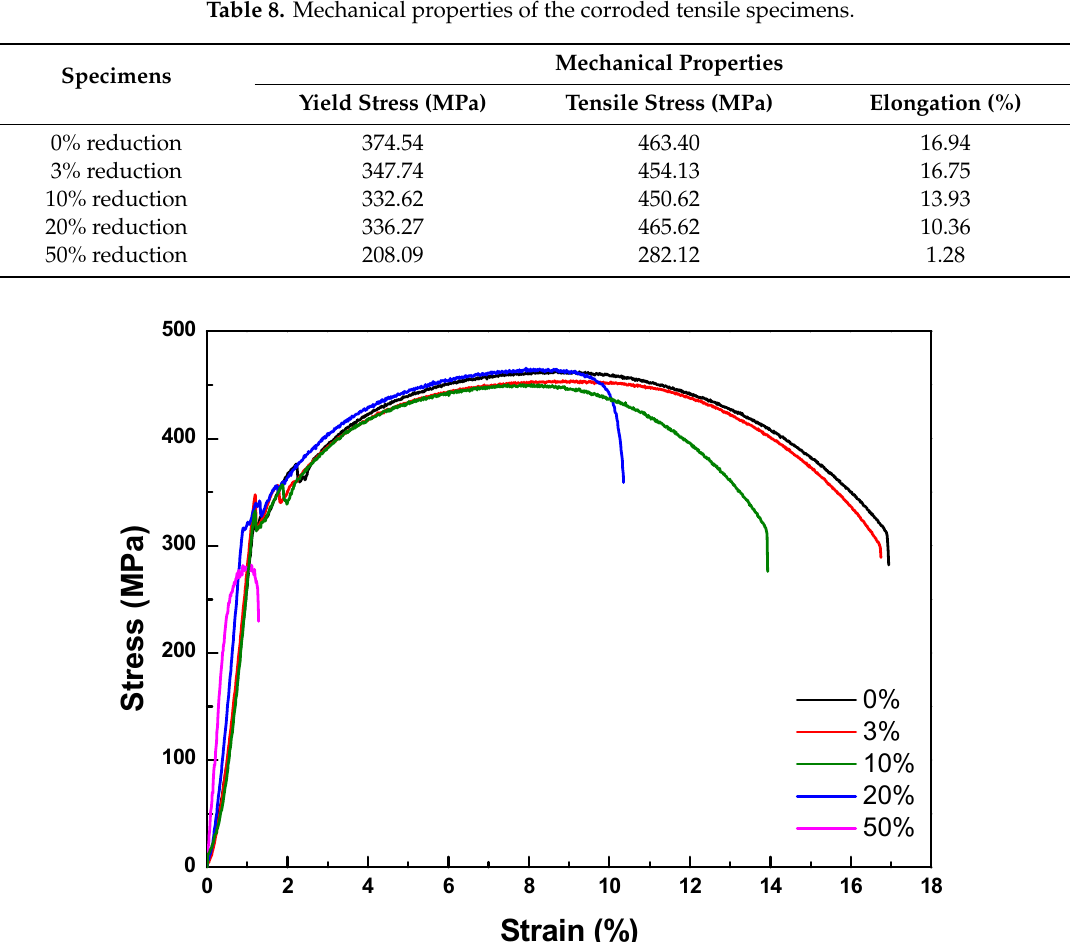
Table 8. Mechanical properties of the corroded tensile specimens.